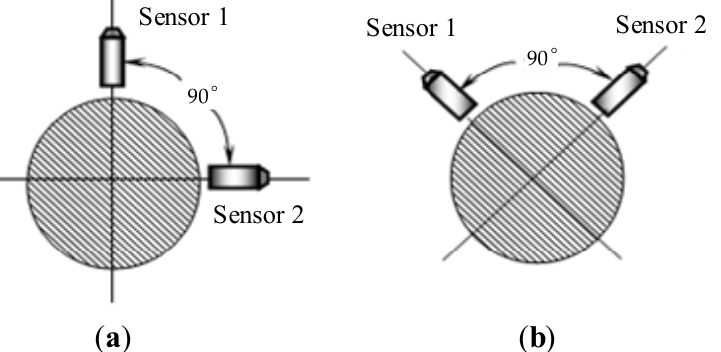
Figure 1. Layout of sensors: ( a ) Being installed in the horizontal–vertical direction; ( b ) Being installed in the V-shaped direction.